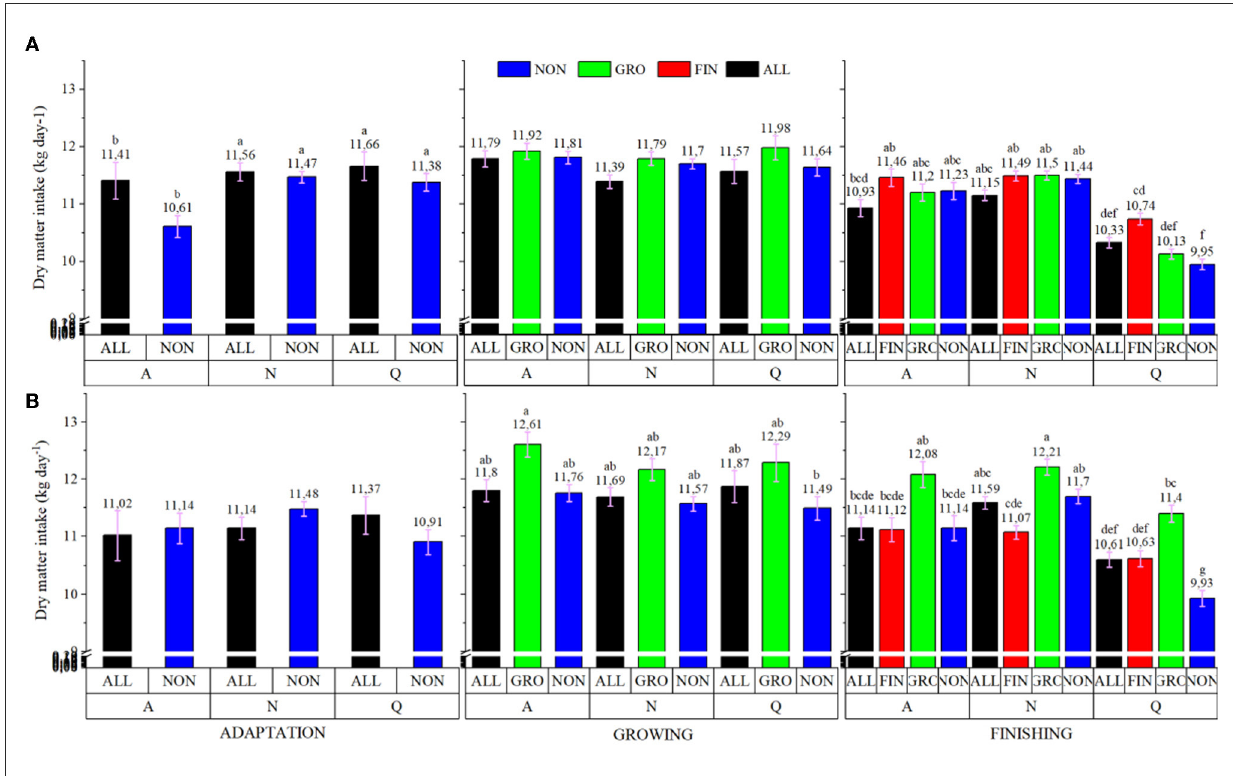
FIGURE3 Breed × Treatment × Day classification interaction of dry matter intake of electronically monitored Bos indicus ( A = Nellore; B = ½ Angus × ½ Nellore) bullocks during adaption, growing and finishing feeding period. NON, Control; ALL, Lysoforte supplementation in all phases (since adaptation); GRO, Lysoforte supplementation starting at growing phase; FIN, Lysoforte supplementation starting at finishing phase. A, rainy, cloudy mild days; N, normal hot days; and Q, very hot days. Within column, different superscripts differs in LSMEANS at P ≤ 0.05.